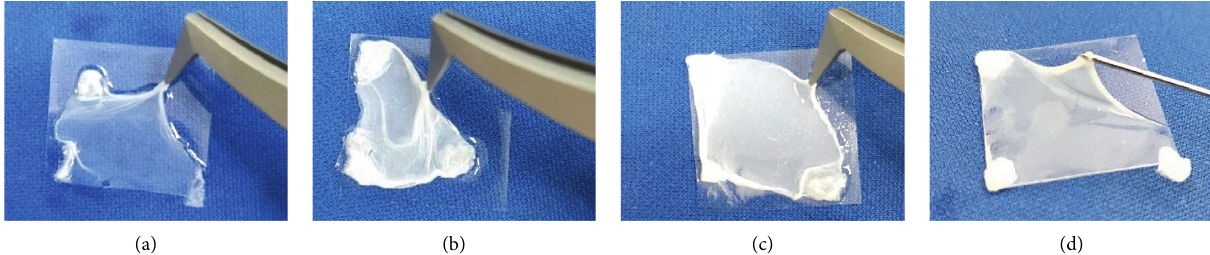
Figure 3: Representative photographs for (a) native and modified fibrin hydrogels at (b) 4mg/mL S, (c) 20mg/mL S, and (d) 0.7 mg/mL CS6 materials.